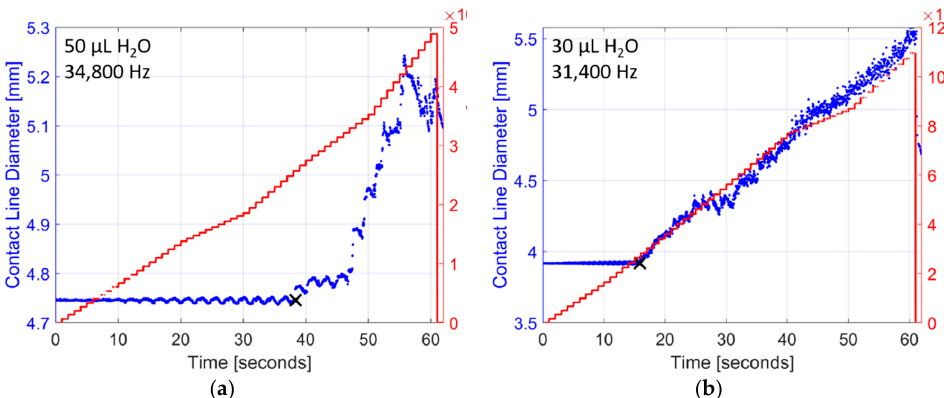
Figure 4. Examples of raw droplet spreading data collected while vibrating droplets of deionized water with a ramped sine wave signal increasing in amplitude (5 V/s) from zero to 300 V: ( a ) a 50 µL droplet vibrated at 34.8 kHz, and ( b ) a 30 µL droplet vibrated at 31.4 kHz. The diameter of each individual droplet begins to increase once acceleration levels are sufficiently high. The initiation of droplet spreading is calculated using a post-processing algorithm and is noted as a black ‘x’ in each example. In most cases the droplet diameter increases linearly with the acceleration response, but stick-slick contact line motion can also occur as observed in ( a ) after the initiation of droplet spreading.